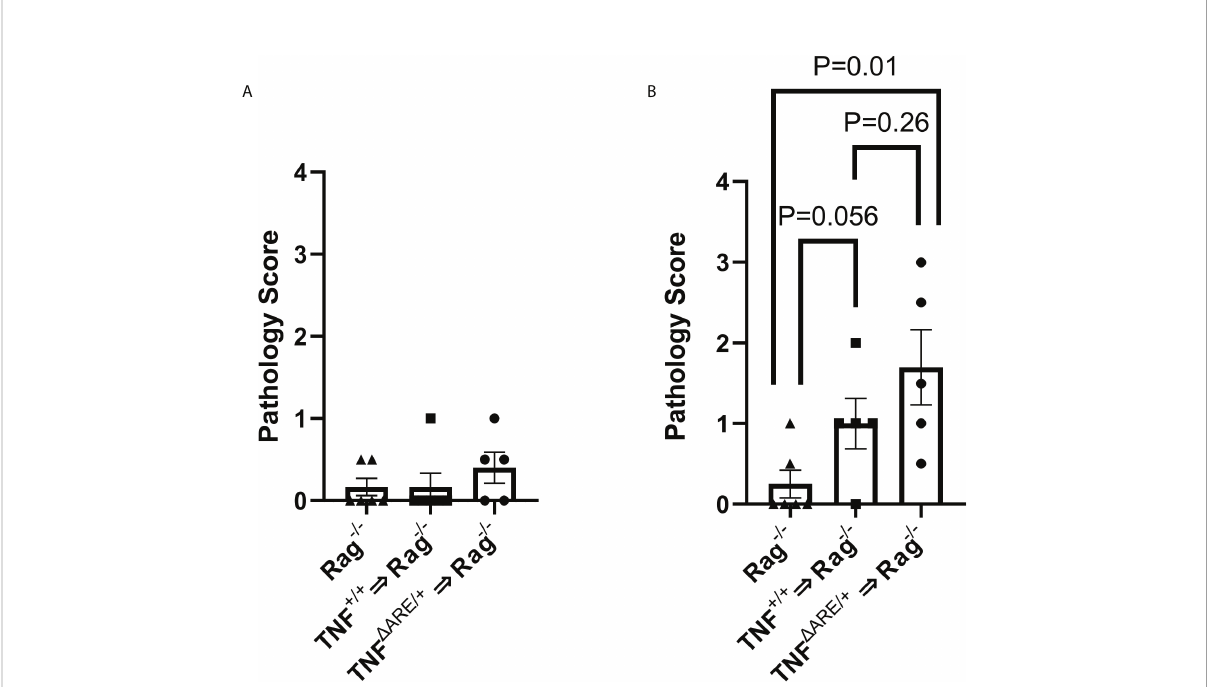
FIGURE 4 IELs from TNF D ARE exacerbate induced joint in fl ammation. IELs from TNF +/+ and TNF D ARE/+ mice were harvested from the colon epithelium, puri fi ed by magnetic negative selection and transferred into Rag1 -/- recipients by tail vein injection; PBS injection was used as a non-transfer control. Following 10 weeks of homeostatic proliferation, recipients of IELs derived from TNF +/+ mice (n=5), TNF D ARE/+ mice (n=5), and Rag1 -/- PBS controls (n=6) received an injection of 20mg CFA in one hind hock and PBS in the other. Mice were euthanized 5 days following hock injections and ankles evaluated histologically. Ankles were scored from 0-4 (0=none; 1=minimal; 2= mild; 3=moderate; 4=severe) on each of the following metrics, and results summed to generate a histopathology score: synovio-enthesitis, cartilage loss, and bone destruction in the (A) PBS-injected hock and (B) CFA-injected hock. Data are shown as individual mice (symbols) with bars as mean ± SEM. P values shown